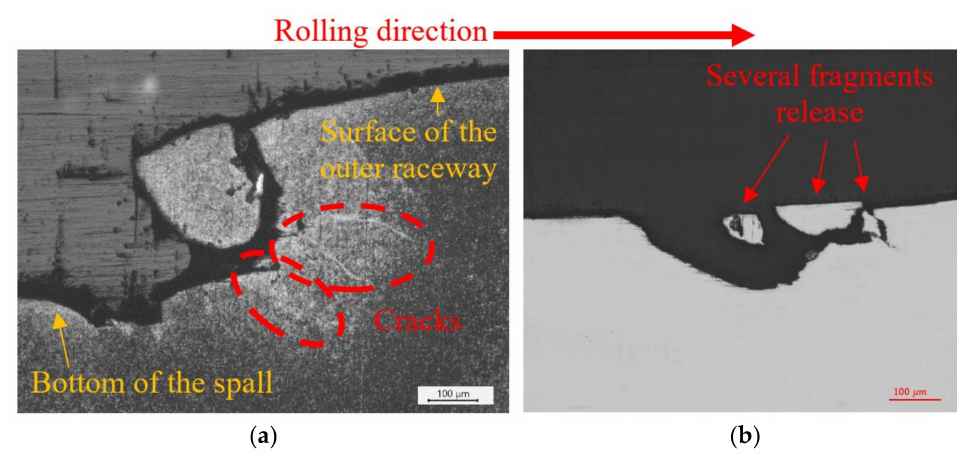
Figure 17. Natural in-service spalls that appeared in a Sikorsky CH-53 helicopter swashplate bear- ing. ( a ) Appearance of sub-surface cracks and fragment release from the trailing edge of the spall. ( b ) Several fragments released from the trailing edge of the